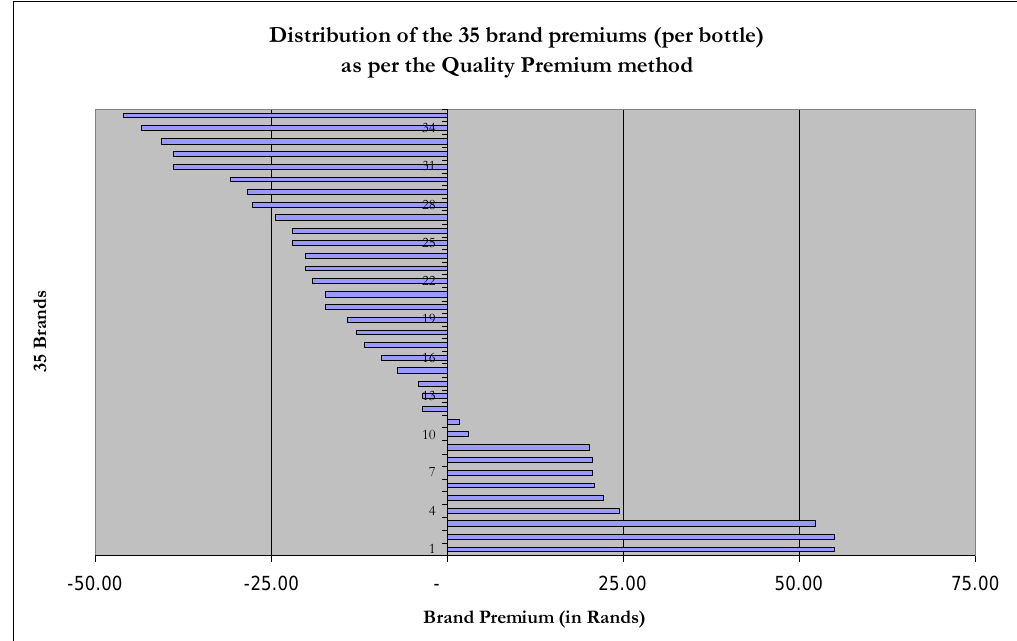
Figure 3: Brand premium distributions for the quality premium brand equity estimate. This we define as the difference between a bottle’s intrinsic value and, instead of price, the value of its perceived quality when the wine is sampled sighted. (Figures in Rands as of 2007.)